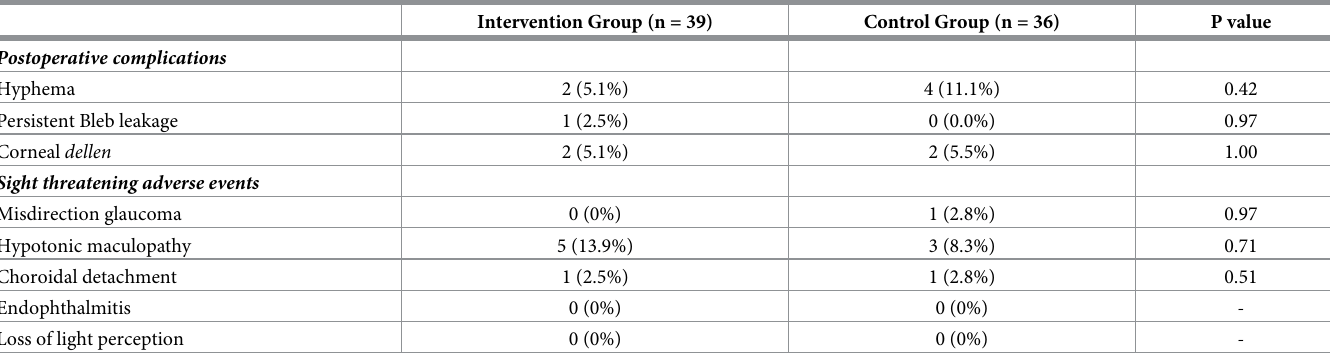
Table 6. Comparison of complication rates between